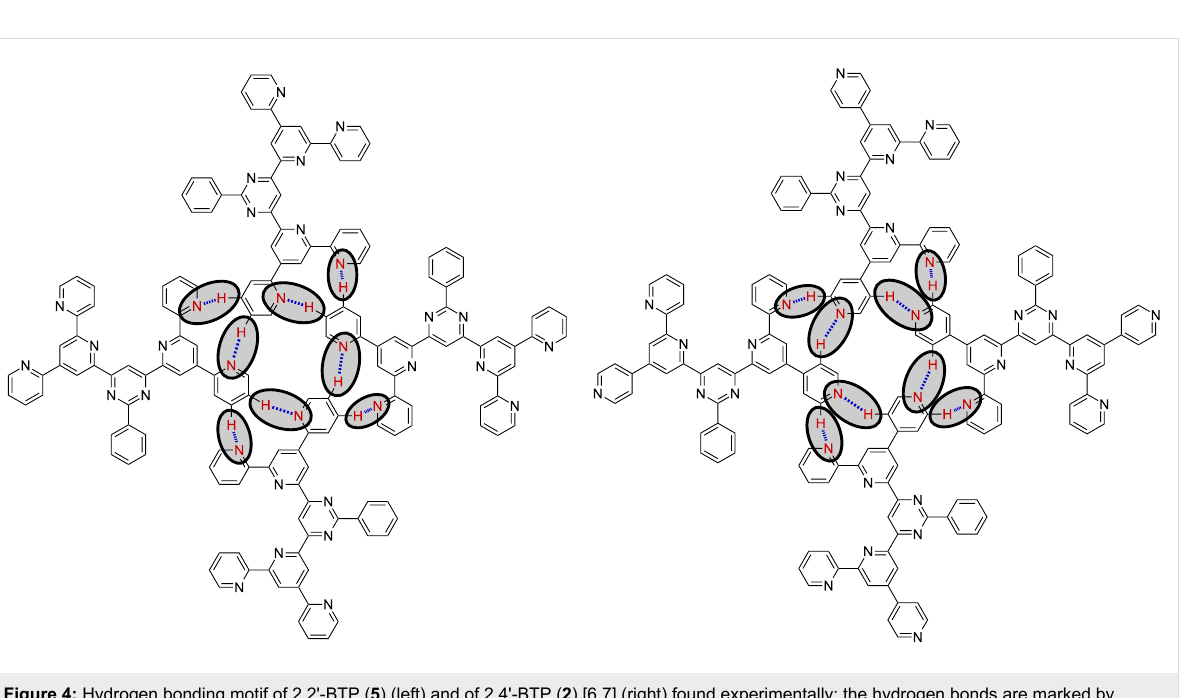
Figure 3: a) 15 × 15 nm 2 STM image ( I set = 14 pA, V set = − 0.64 V) of 2,2'-BTP ( 5 ) at the HOPG/TCB interface [ a = 3.0 ± 0.2 nm, b = 3.0 ± 0.2 nm, a,b = 91 ± 2°] with four overlaid molecules; b) model of the 2,2'-BTP ( 5 ) square pattern.